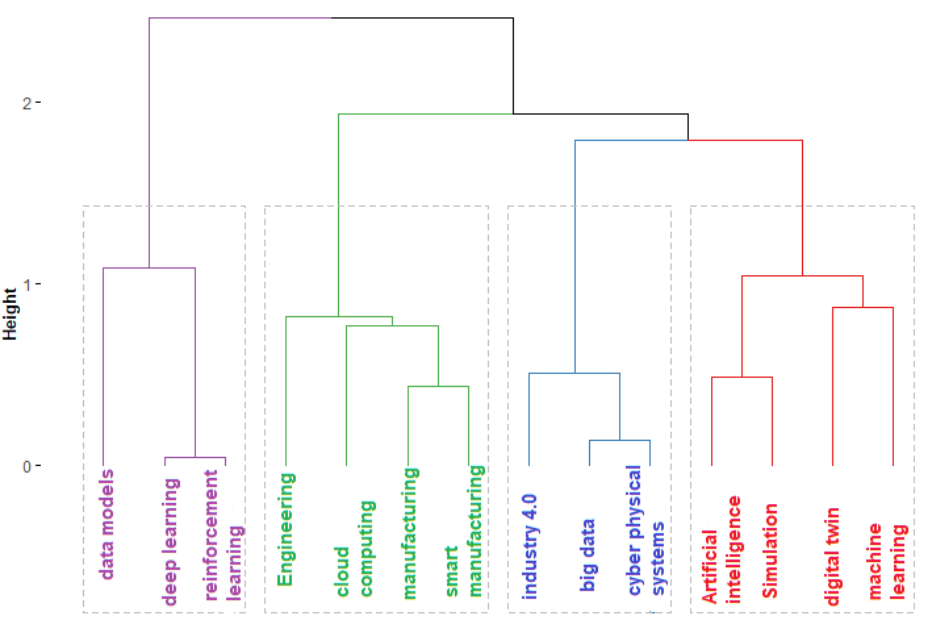
Figure 8. Topic dendrogram with four clusters. A dendrogram with four clusters of author keywords. Distance between keywords is directly proportional to co-occurrence